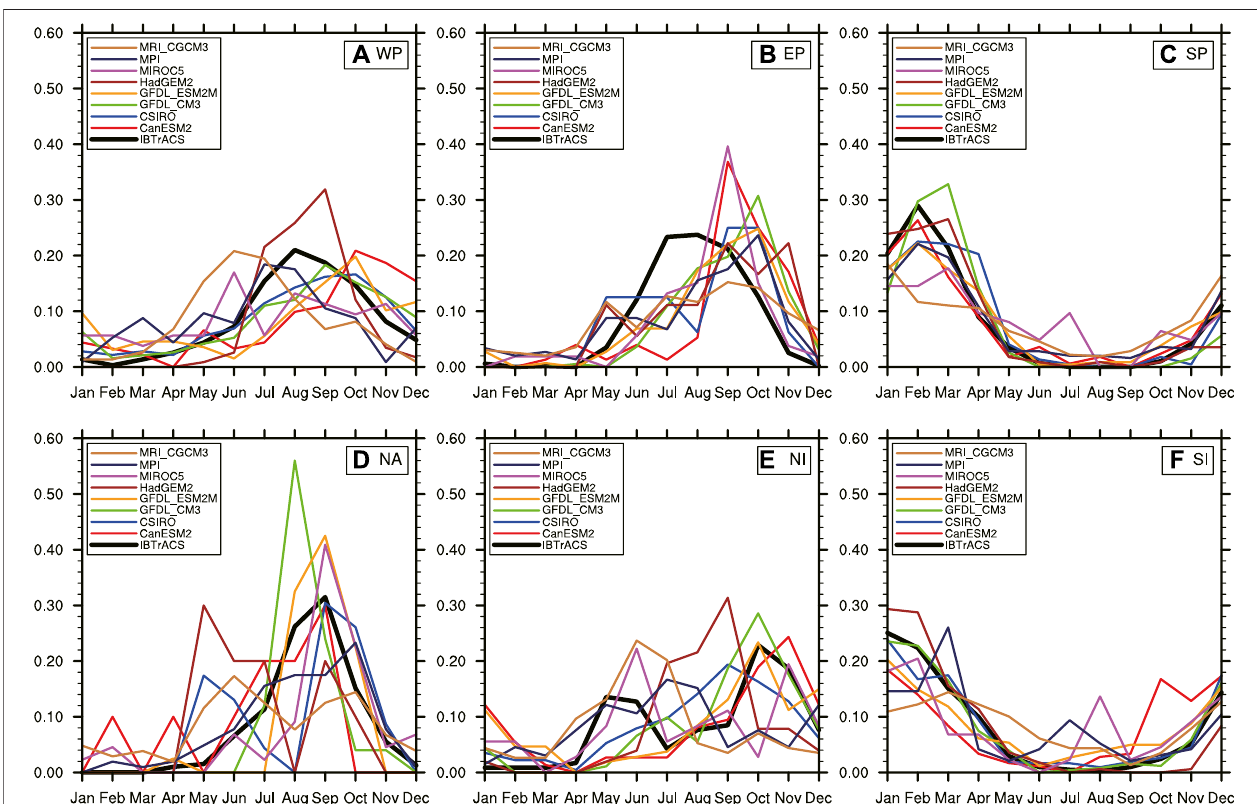
FIGURE 4 | Variation in the proportion of monthly mean TC frequency to annual-mean TC frequency averaged over the period 1980 – 2015 in the six areas from observationsandmodelsimulations.Theabscissaismonth,andtheordinateisTCfrequencyproportion.Theblackcurverepresentsobservations,andtheothercurves represent the results of the eight CMIP5 models.